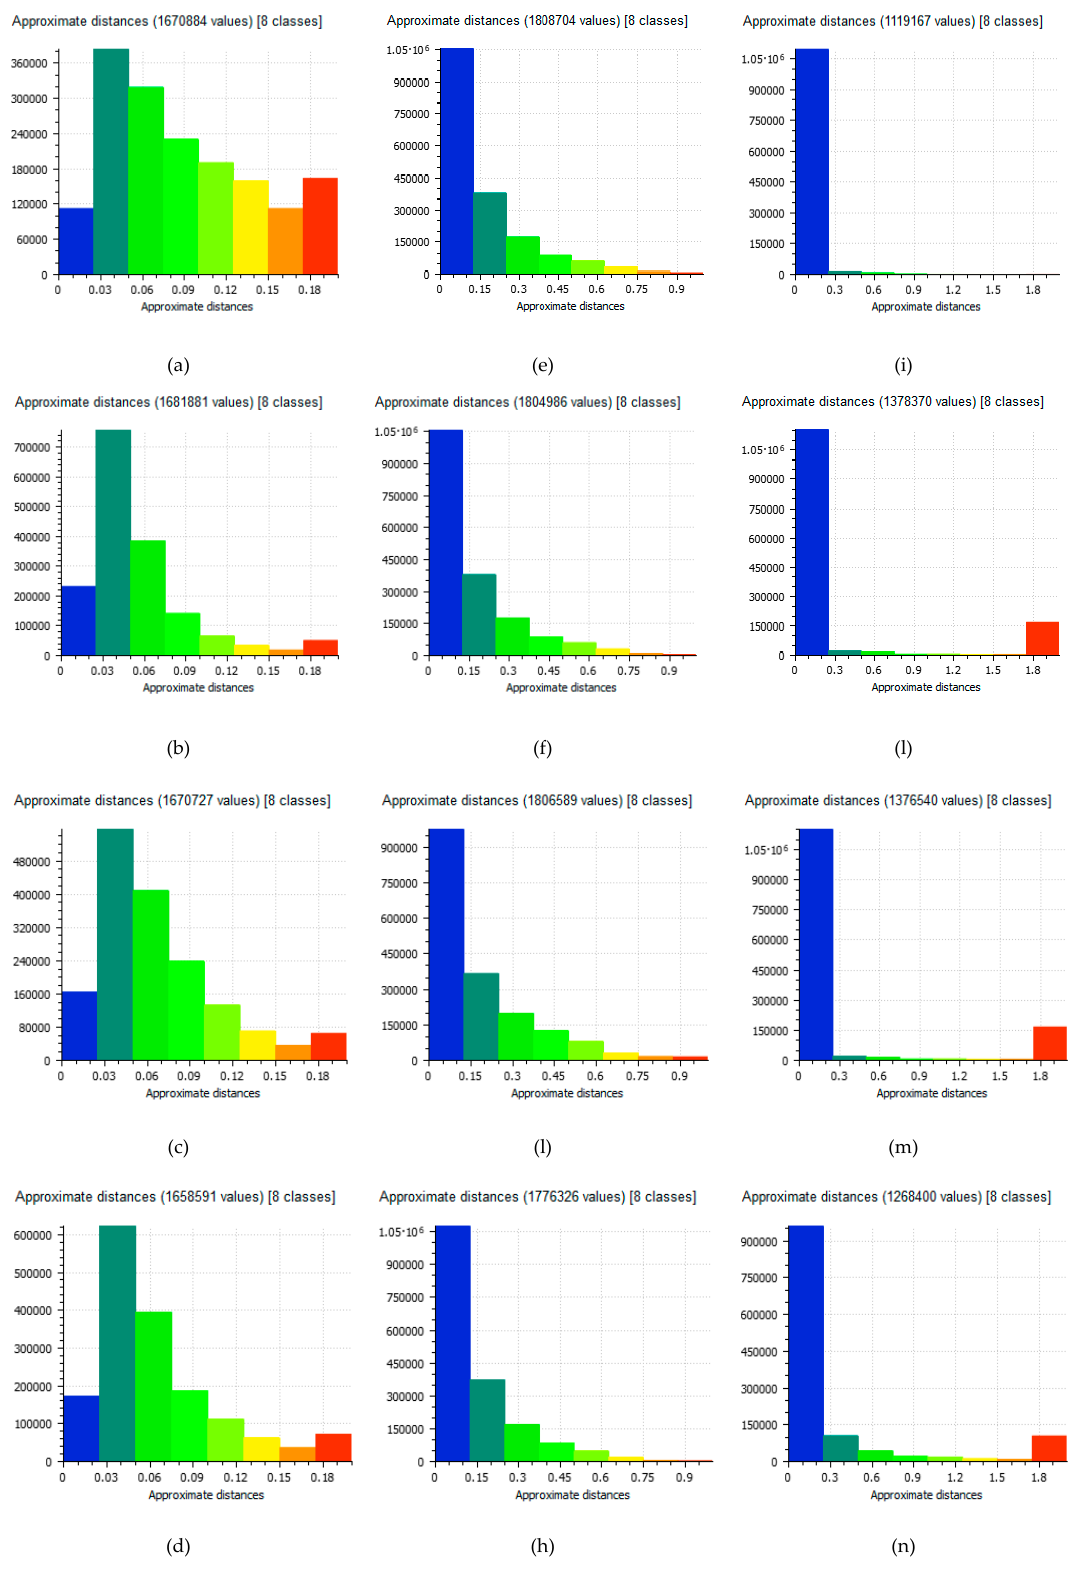
Figure 4. Histograms of difference between the point cloud generated by DNG images and the other point clouds generated by several format e level of JPEG compression: test site 1: TIFF ( a ), JPEG12 ( b ), JPEG6 ( c ), JPEG1 ( d ); test site 2: TIFF ( e ), JPEG12 ( f ), JPEG6 ( g ), JPEG1 ( h ); test site 3: TIFF ( i ), JPEG12 ( l ), JPEG6 ( m ), JPEG1 ( n ).